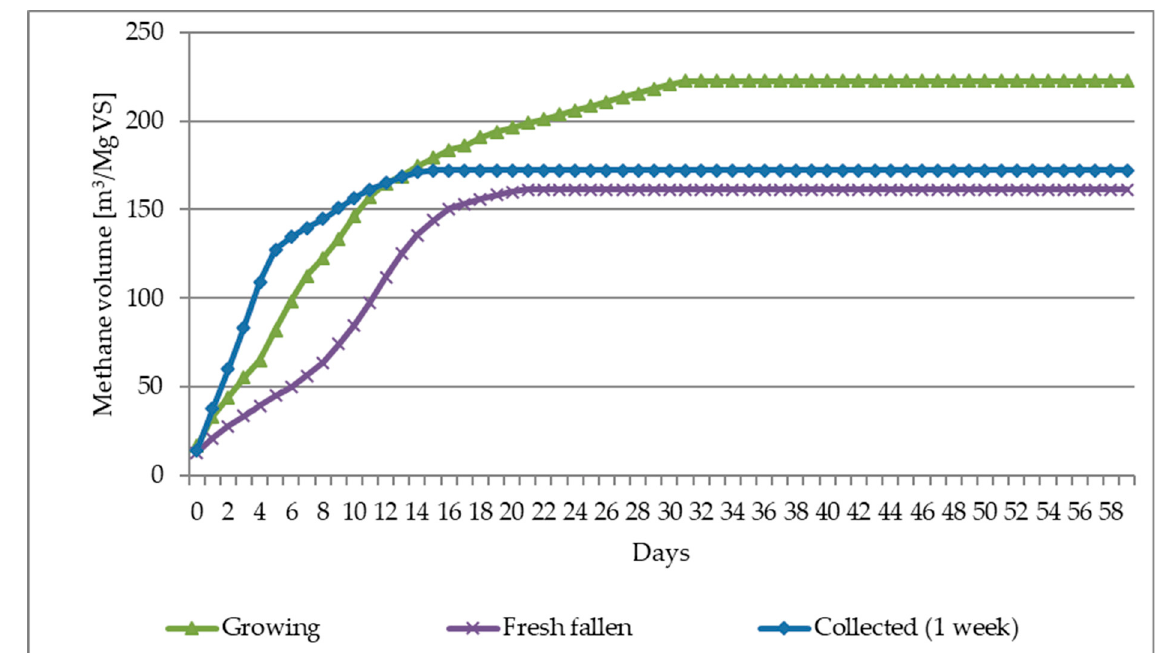
Figure 8. Biogas production from dry organic mass in time.